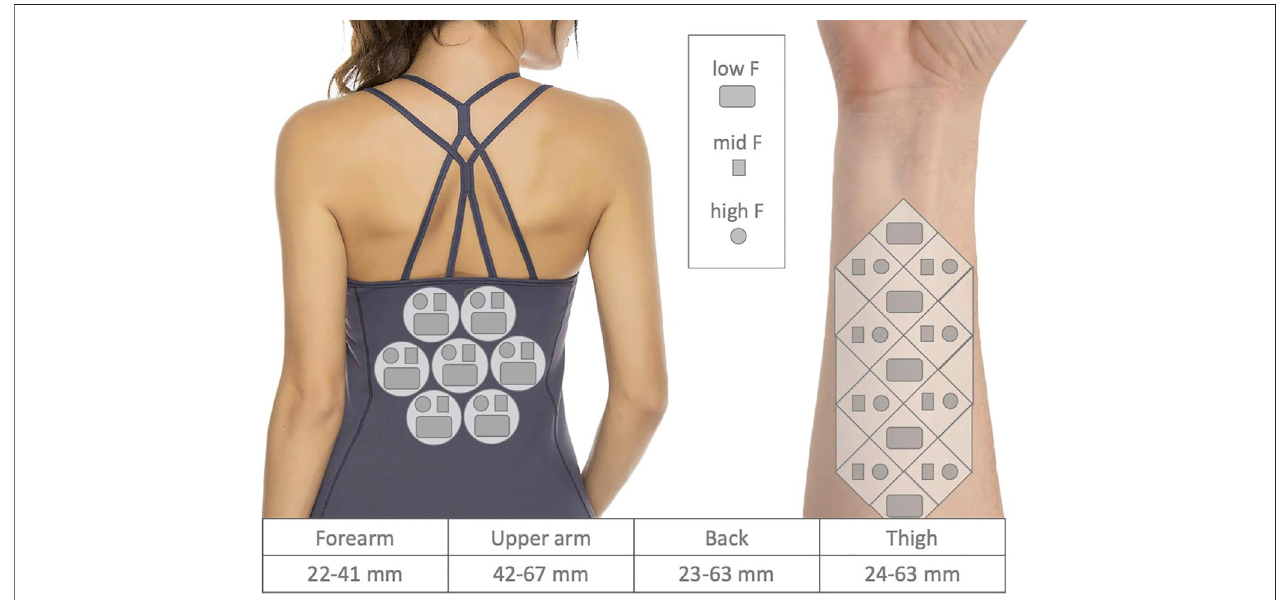
FIGURE 10 | Illustration of interleaving narrowband tactors in a wearable haptic display worn on the back or volar forearm. The large circles on the back and the diamonds on the forearm indicate spatially distinct areas of stimulation. The legend shows the three types of narrowband tactors. The table at the bottom lists the two- point limens at select body sites (from (Weber, 1834/1978; Weinstein, 1968; Mancini et al., 2014)).